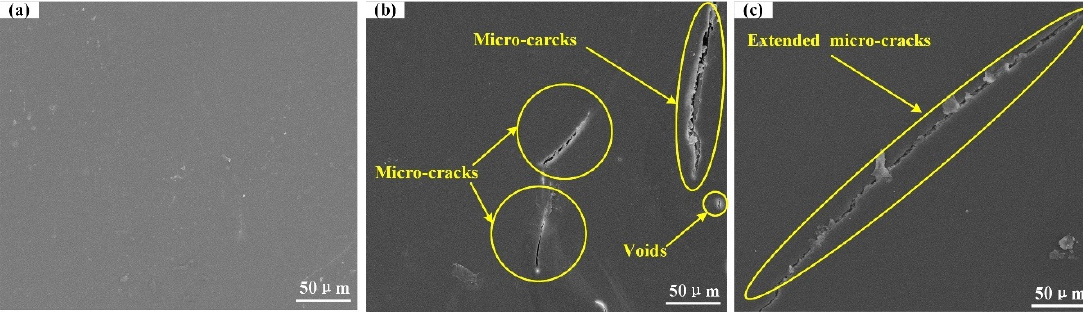
Figure 5. SEM images of ( a ) unaged specimen surface; Aged surfaces of the specimens soaked ( b ) deionized water and ( c ) alkaline solution at 60 °C after 180 ageing days.